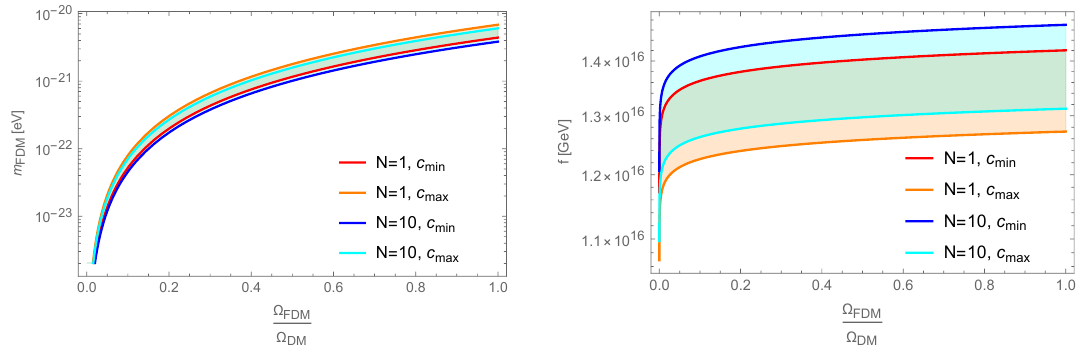
Figure 2 . Predictions for axion mass (left) and decay constant (right) varying the percentage of axionic FDM and the non-perturbative effects giving rise to the ALP potential.